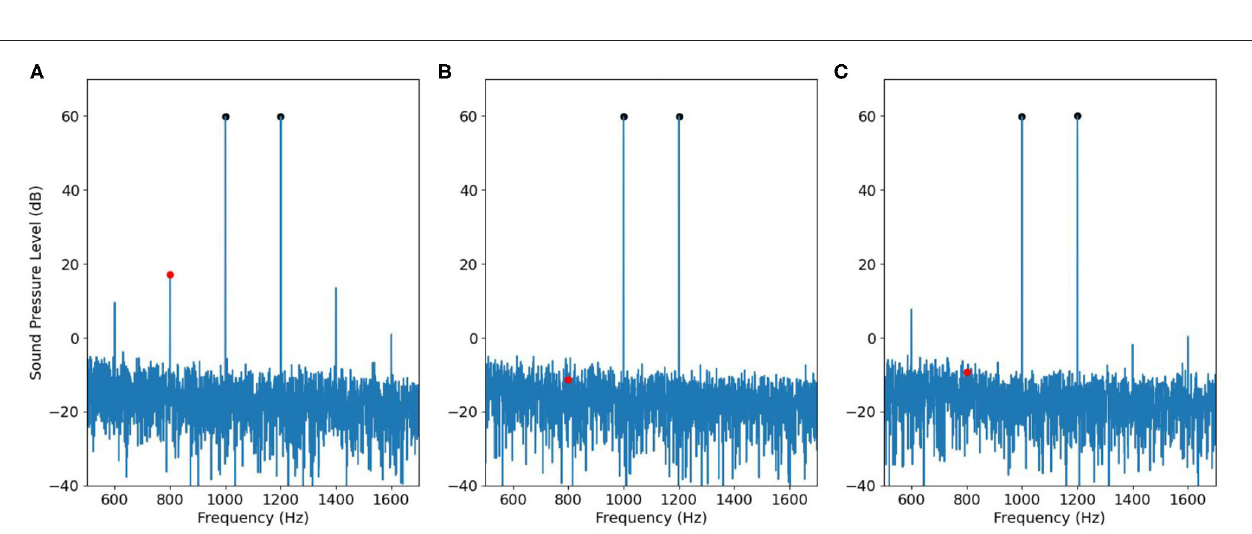
FIGURE 9 | Effectiveness of ODVF in canceling IMD3 in a syringe, visualized in the frequency domain. (A) The signal recorded by using a single speaker. (B) The signal recorded by using two speakers. (C) The signal recorded by using the adjusted input signal in Figure 5